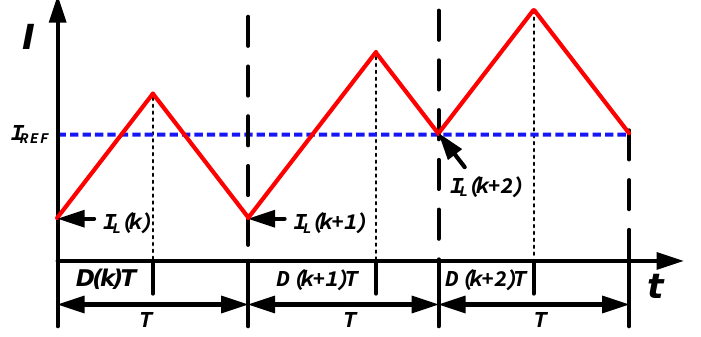
Figure 2. Current waveform under valley current control and TE